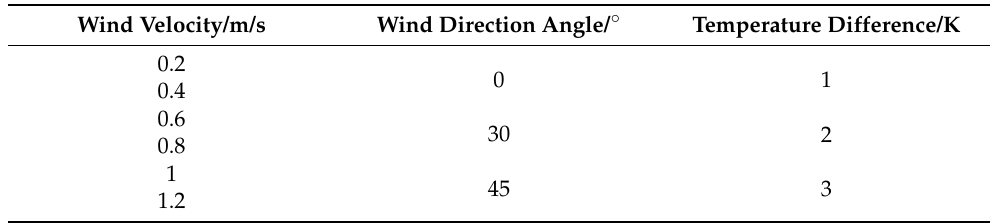
Table 2. Boundary